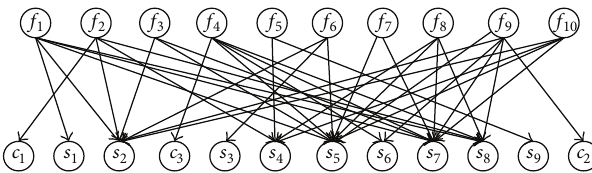
Figure 5: Integrated fault diagnosis model proposed in this